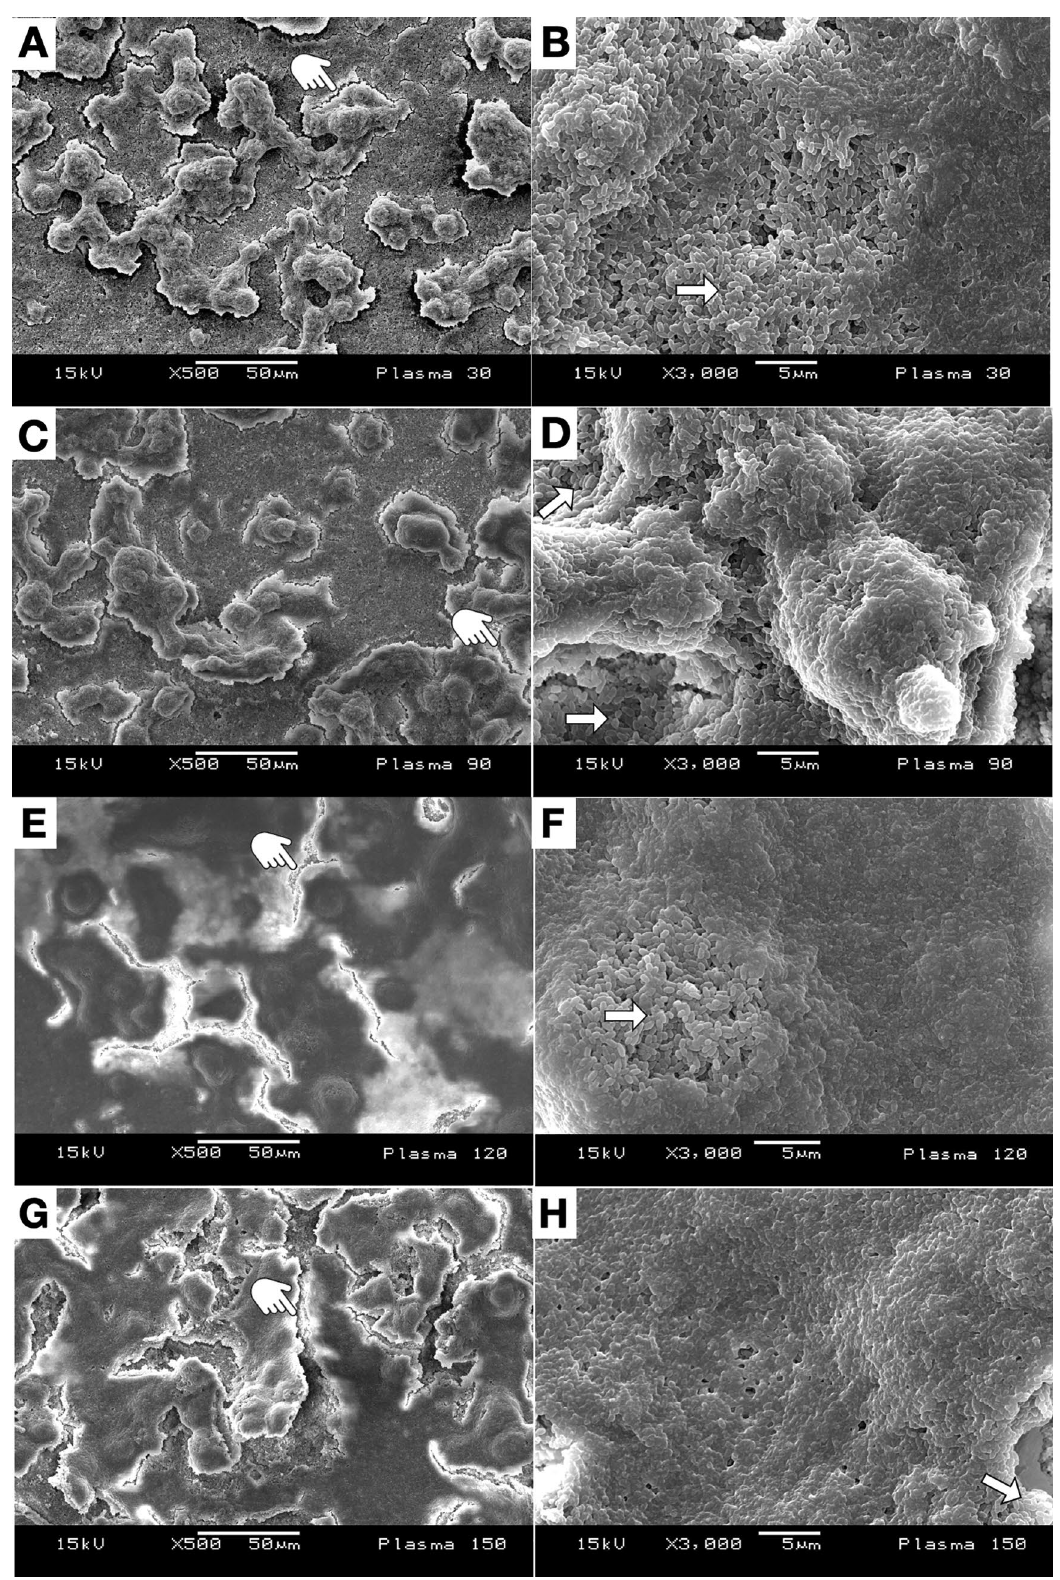
Figure 4. Representative SEM micrographs of the S. mutans biofilm (24 h, X500 and X3000 magnification), after NTAP treatment for P30 ( A , B ); P90 ( C , D ); P120 ( E , F ); and P150 ( G , H ). More damage on the biofilm structure was observed with the increase of the NTAP application. Note the presence of “non-disrupted” / untreated biofilm (white arrows) and some ruptures occurred on the biofilm due to effects of drying